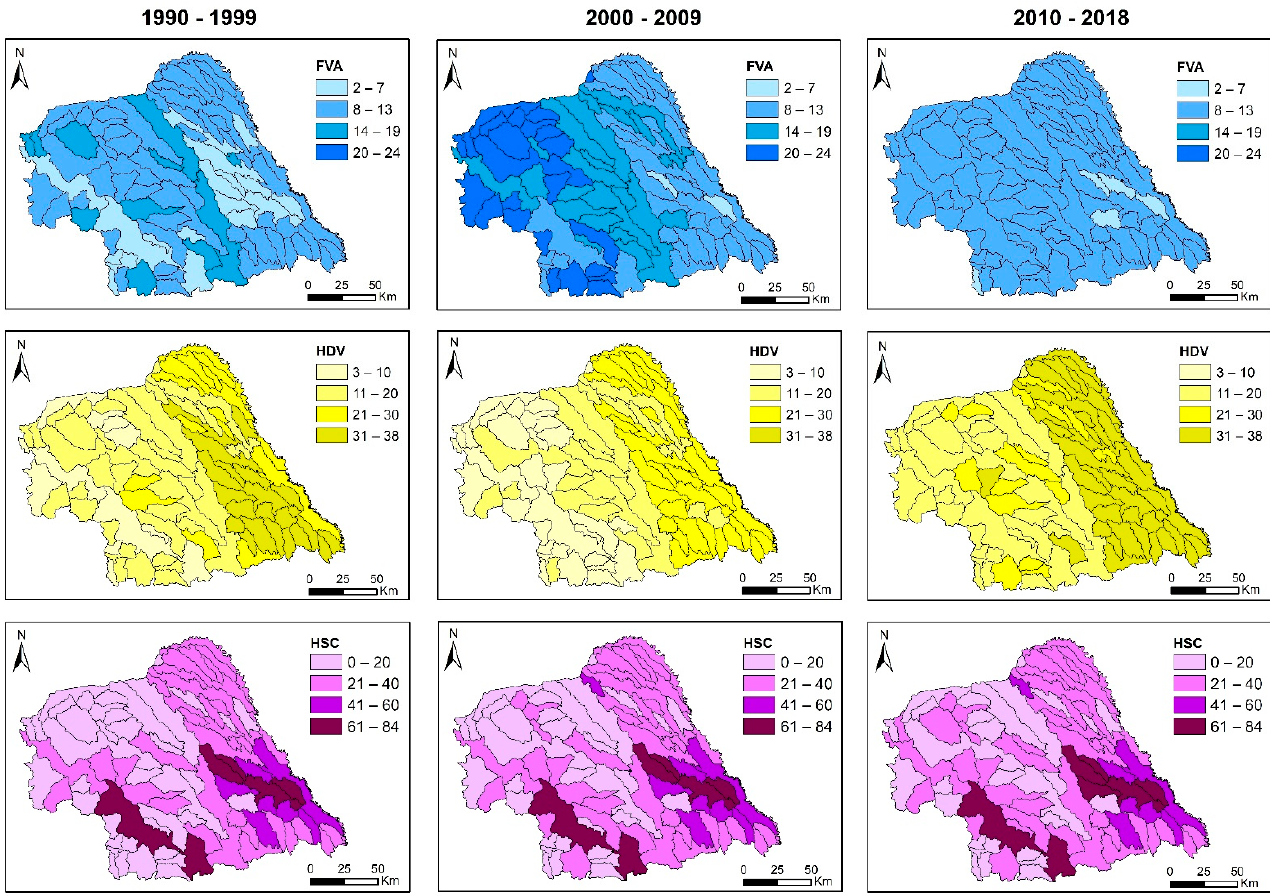
Figure 4. The evolution of the hydrological factors’ values in the study area.